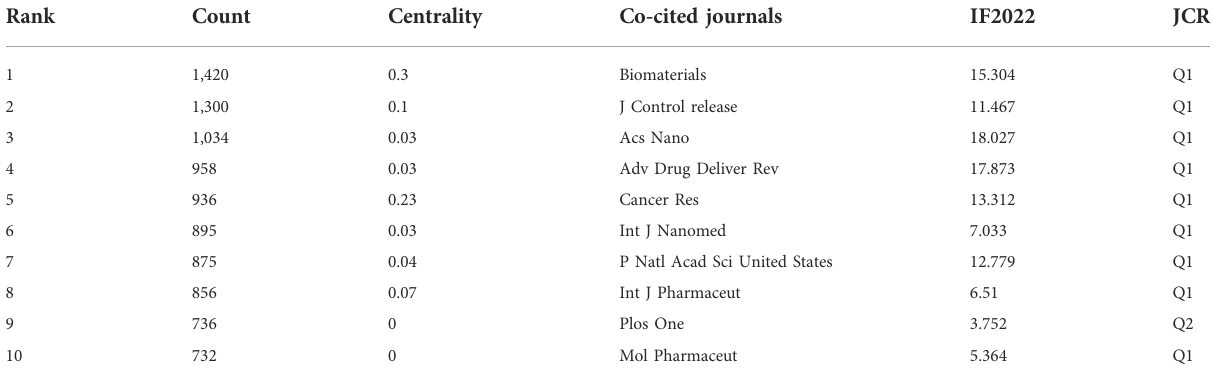
TABLE 3 Top ten co-cited journals for related publications.